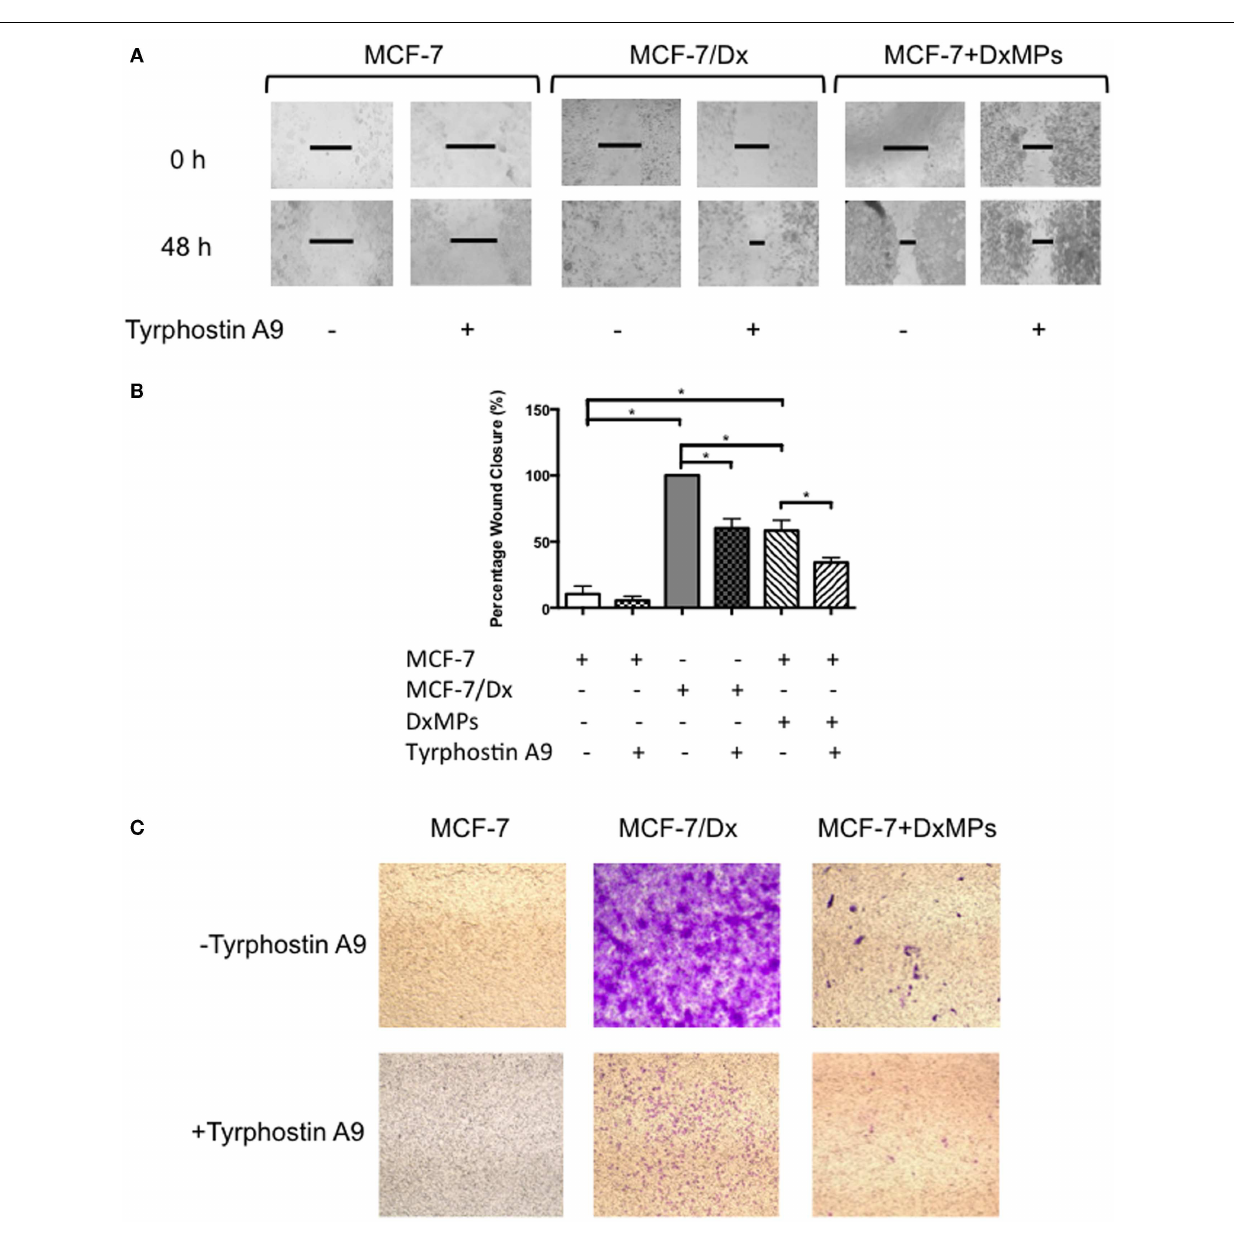
FIGURE 6 | Inhibition of PYK2 phosphorylation is associated with decreased migratory capacity . (A) Migratory capacity of breast cancer cells.Wound healing/scratch migration assays of MCF-7 cells, MCF-7/Dx cells, and co-cultured cells demonstrate the migration capacity of each cell type and the effect of the PYK2 phosphorylation inhibitor tyrphostin A9 on this capacity. Cells were incubated without or with tyrphostin A9 and closure of the wound was assessed after 48h. Data was representative of at least three independent experiments. (B) Histograms showing the percentage wound closure in breast cancer cells.The percentage wound closure observed in ( ): MCF-7 cells without tyrphostin A9, ( ): MCF-7 cells with tyrphostin A9, ( ): MCF-7/Dx cells